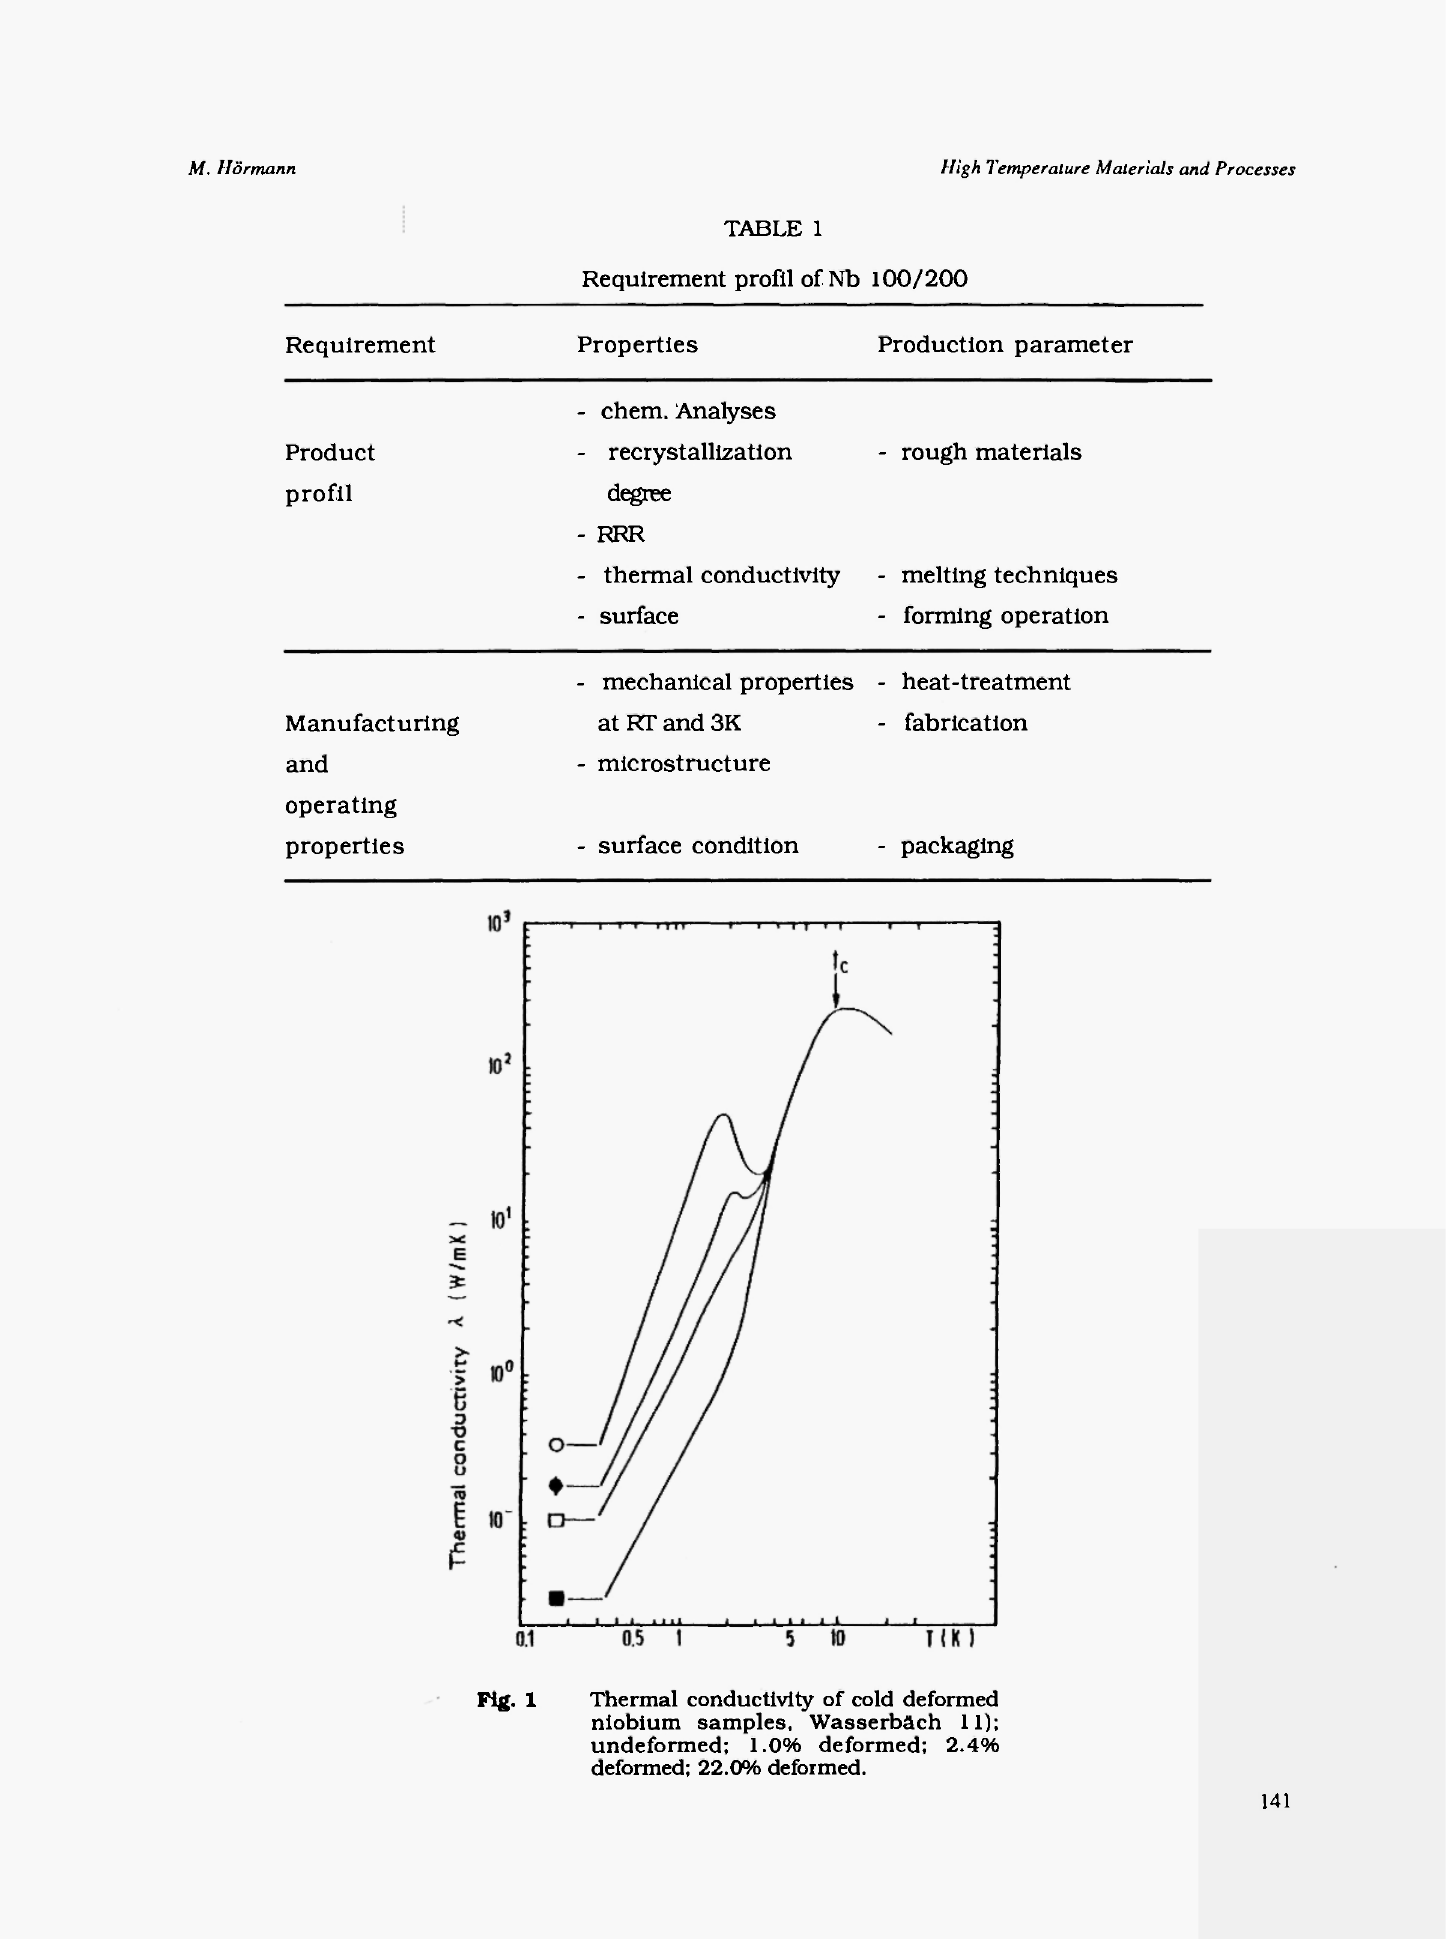
Flg. 1 Thermal conductivity of cold deformed niobium samples,